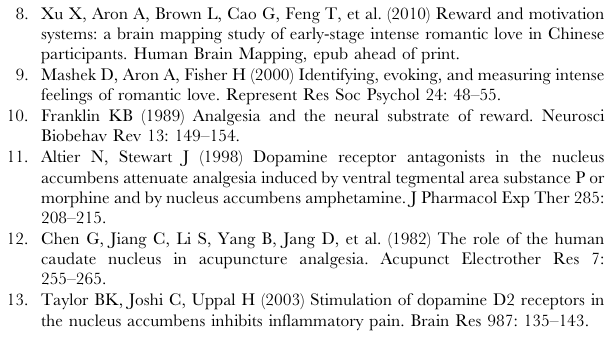
Table S2 List of regions associated with analgesia during a distraction task. All significant clusters are seen in aggregated moderate- and high-pain trials. Reported clusters survived a voxel- level, uncorrected p , .005 (corresponding to a t-value of 3.01), and a cluster-level threshold of 64 contiguous voxels. The region name is listed, followed by coordinates (MNI), t-score at the peak voxel, and cluster size. L =left, R= right, B=